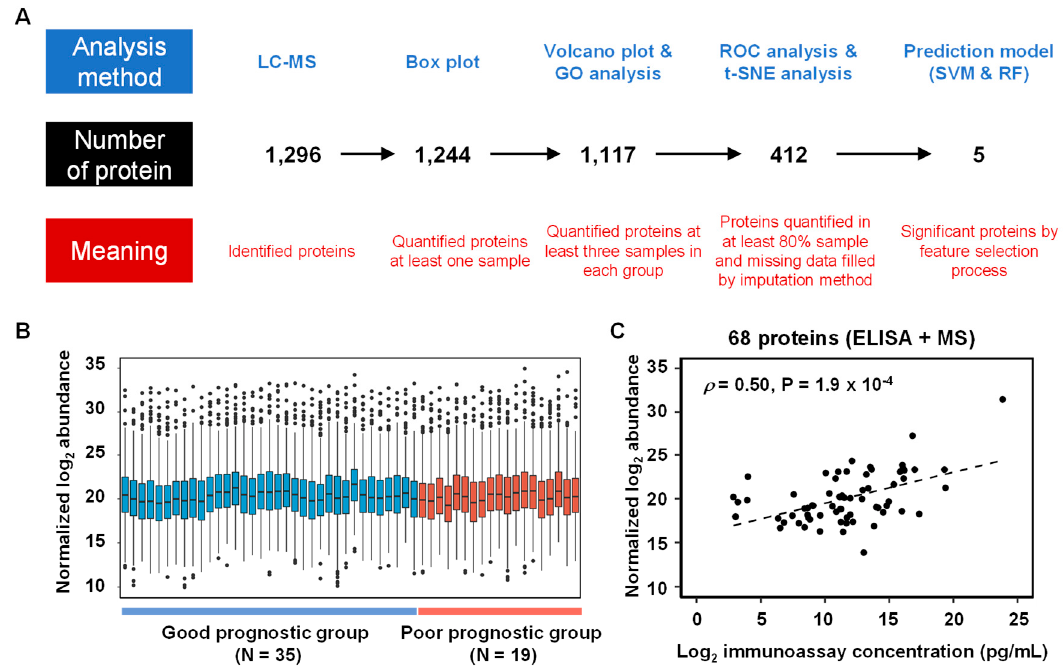
Figure 1. ( A ) Analysis workflow of urinary proteins in the 54 diabetic kidney disease (DKD) patients. The analysis method is written in the upper part, the number of proteins in the middle, and the meaning of the protein in the bottom part. ( B ) Boxplots of normalized urinary protein abundances in the 54 samples (35 patients in good-prognostic group and 19 patients in poor-prognostic group) measured by LC-MS analysis. ( C ) Scatter plot of 68 urine proteins between normalized log2 abundance and log2 immunoassays concentration (Pearson correlation coefficient ( ρ ): 0.5 and p -value: 1.9 × 10 − 4 ).